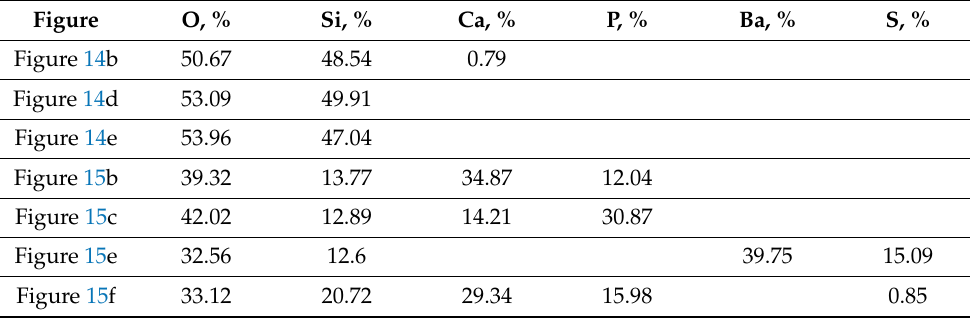
Table 2. The weight percentage of chemical